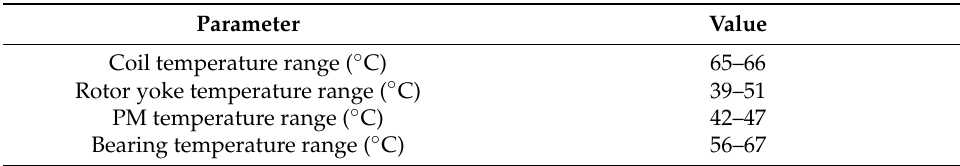
Table 6. Thermal analysis results.